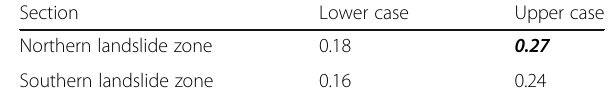
Table 1 Threshold horizontal ground accelerations (g) of longitudinal models of Quyon landslide Section Lower case Upper case Northern landslide zone 0.18 0.27 Southern landslide zone 0.16 0.24